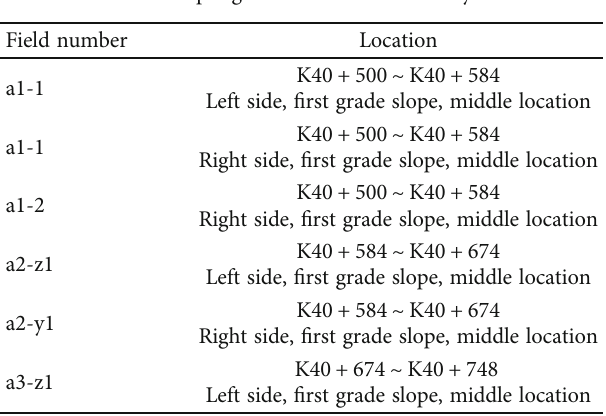
Table 2: Sampling location of weak interlayer soil.